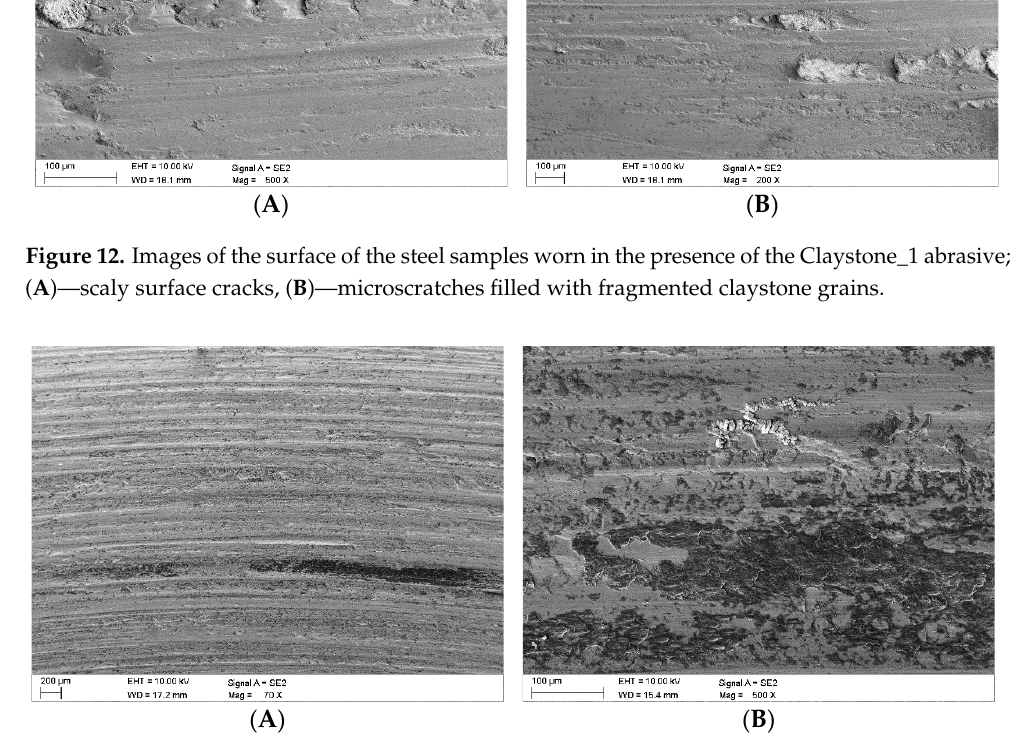
Figure 13. Images of the surface of the steel samples worn in the presence of the Claystone_2 abrasive; ( A , B )—microcracks filled with coal matter contained in the claystones.